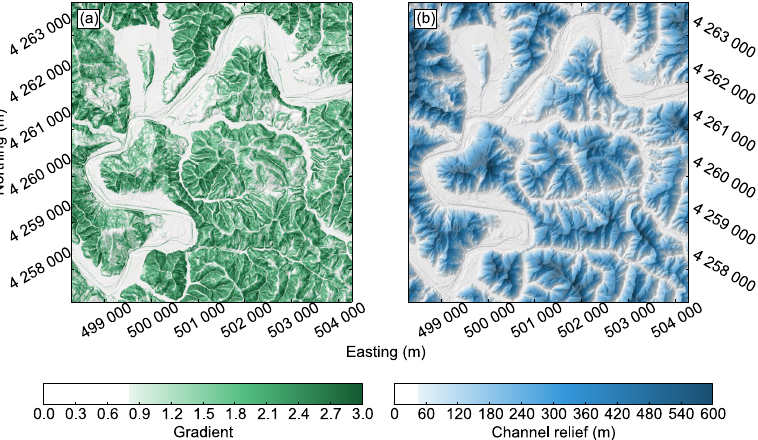
Figure 3. Maps showing (a) gradient and (b) relief relative to the nearest channel, R c , for the Russian River field site. The areas of the landscape identified as below the threshold are shown in white, with values above the threshold then grading to darker colours. In order to be selected as floodplain, each pixel must be below the threshold for both gradient and R c . The coordinate system is UTM Zone 10 ◦ N.